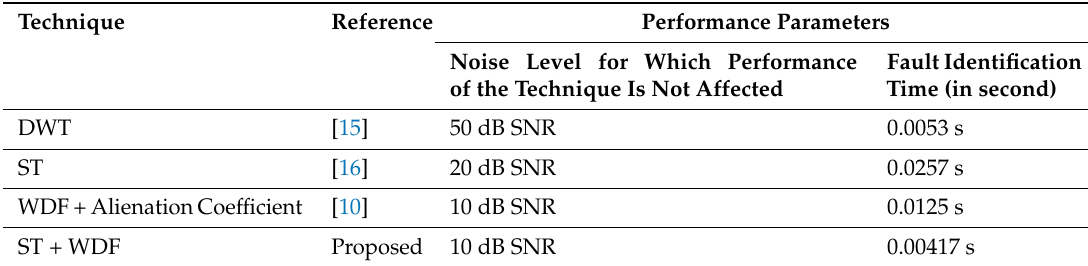
Table 7. Performance Comparative Study of Fault Recognition